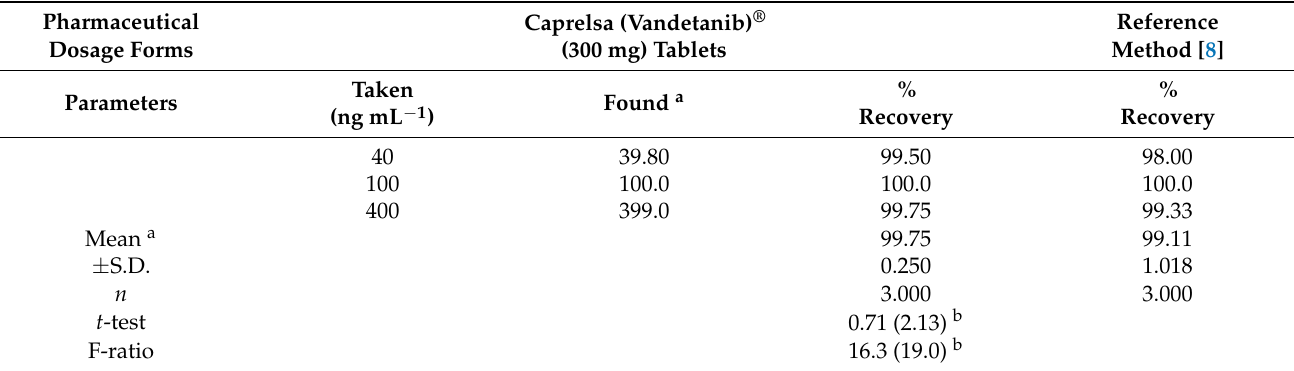
Table 5. Determination of VNB in pharmaceutical dosage forms.